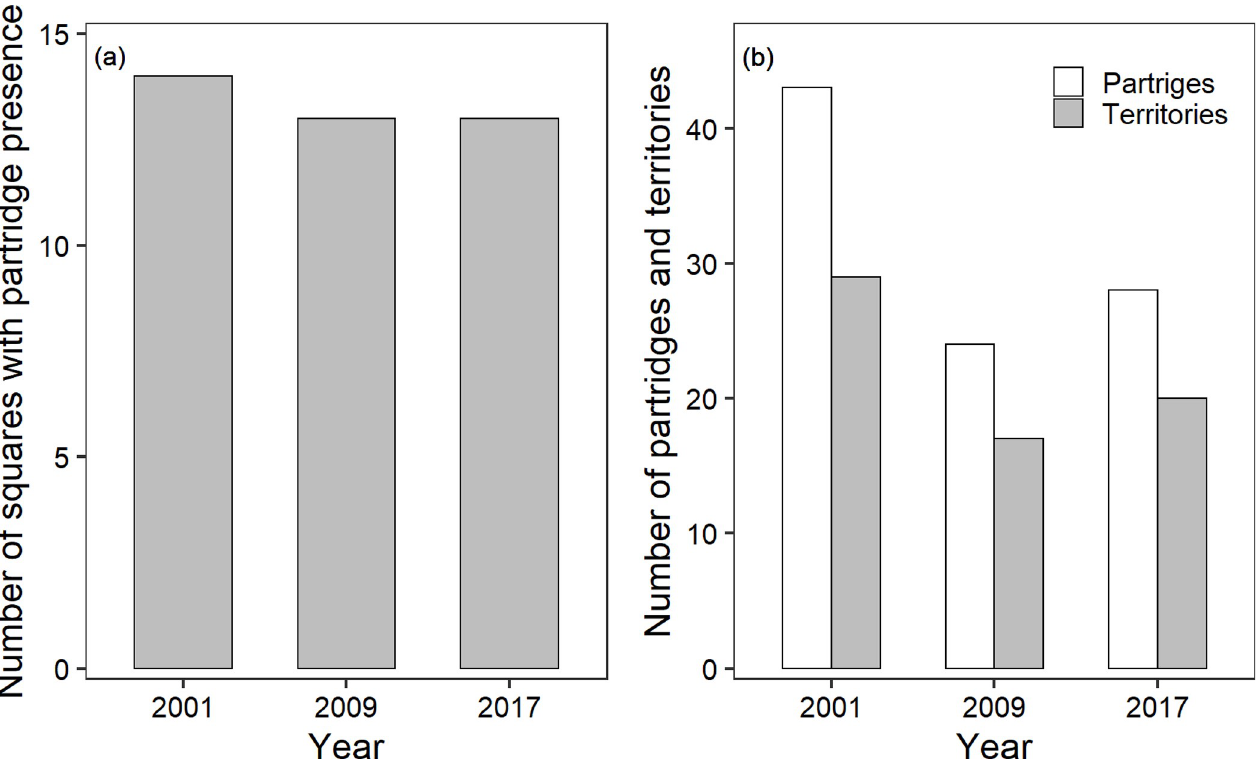
Fig 1. Habitat occupation of grey partridges in Vienna district. Habitat occupation of grey partridges in Vienna district for the years 2001, 2009 and 2017 differing between (a) numbers of squares with grey partridge presence and (b) numbers of grey partridge individuals (white) and numbers of territories (grey).